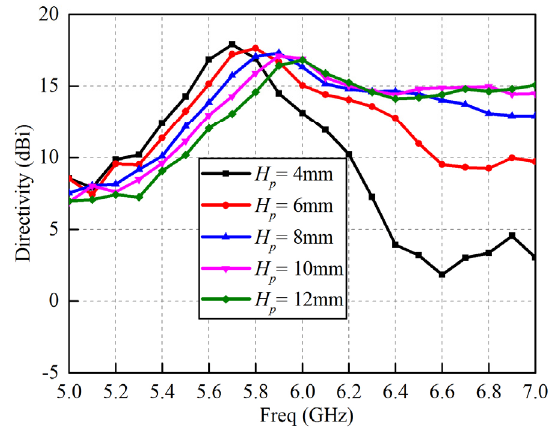
Figure 7. Gain-frequency response against H p for proposed Figure 7. Gain–frequency response against H p for proposed FPRA. Figure 7. Gain–frequency response against H p for proposed FPRA.